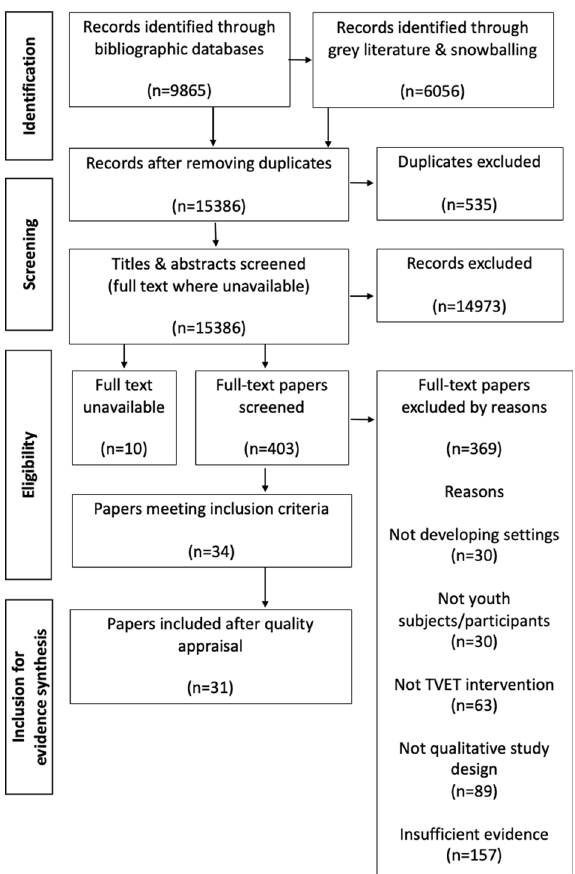
Fig. 1 PRISMA Flow Diagram of the Study Selection